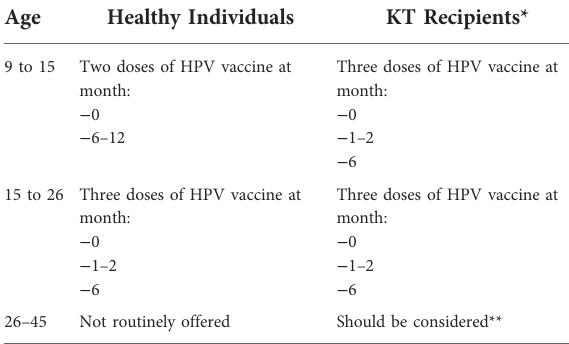
TABLE 1 Dosing and timing recommendations for HPV vaccine